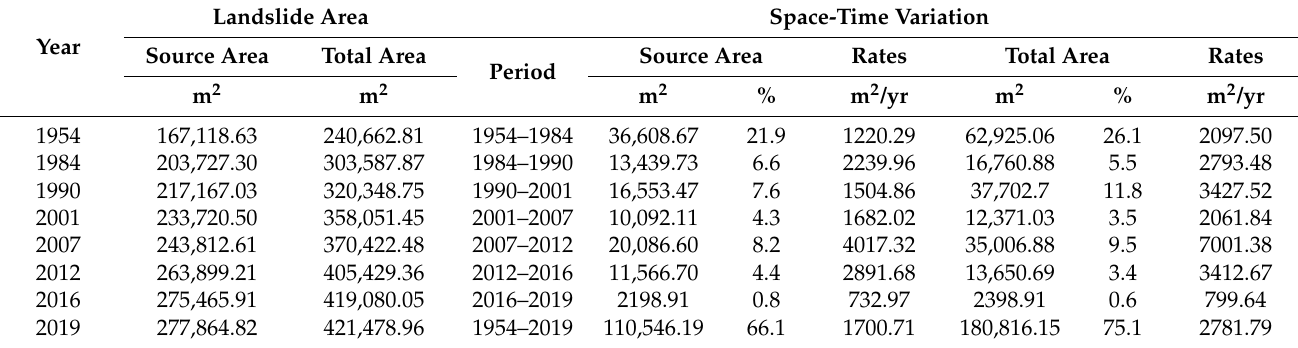
Table 4. Areal variations of the Vomice earthflow from 1954 to